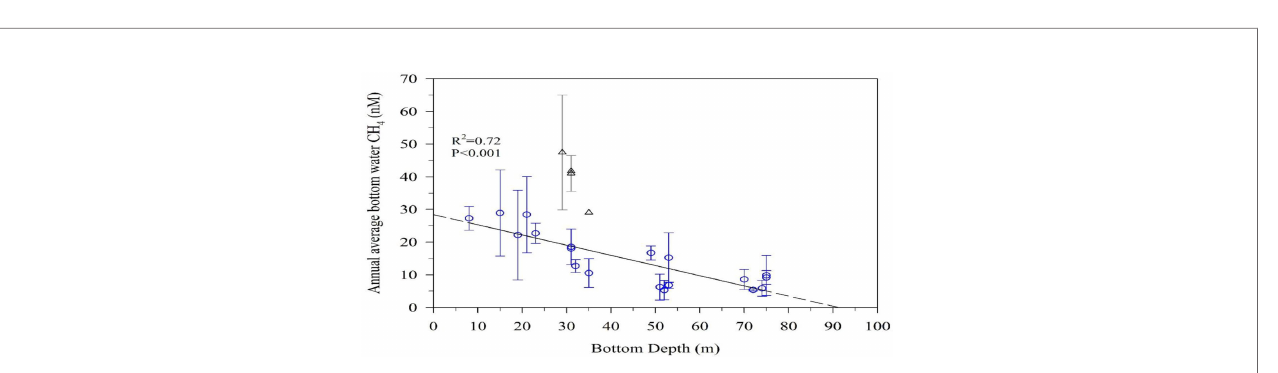
FIGURE 6 | The annual average bottom water CH 4 concentrations (nM) versus bottom depths (m), obtained at 62 stations during four cruises from November 2019 to January 2021. D presents the data in fl uenced by ocean outfall pipe of wastewater treatment plant, which has been excluded in the